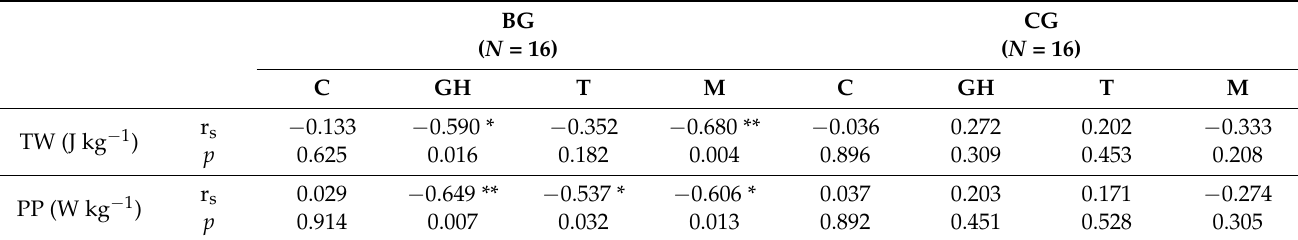
Table 4. Results of the Spearman’s signed-rank correlation test examining the relationship between total work and peak power and the hormones measurements from 10:00